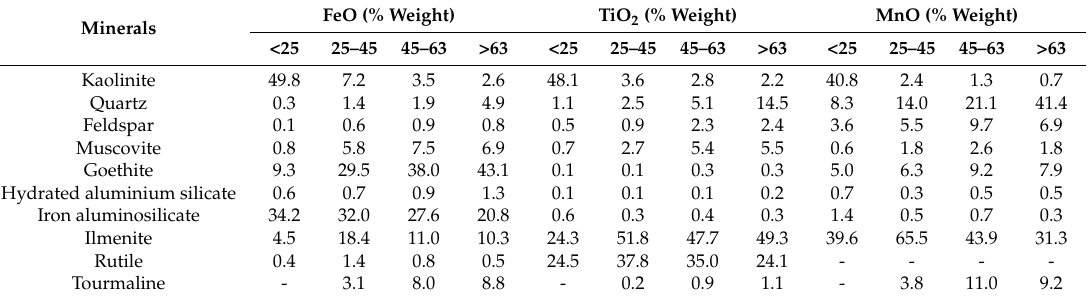
Table 2. Distribution of FeO, TiO 2 , and MnO (%) in minerals, measured by electronic microprobe. Minerals